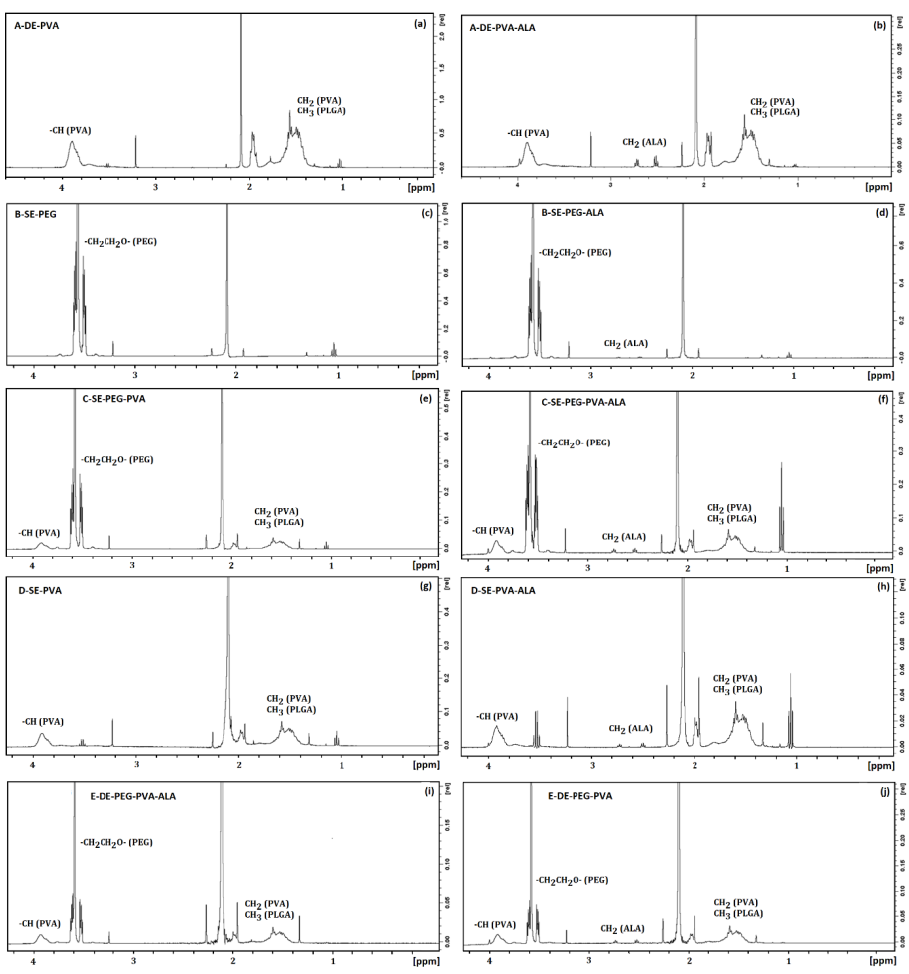
Figure 6. NMR spectra of ( a ) A-DE-PVA, ( b ) A-DE-PVA-ALA, ( c ) B-SE-PEG, (d) B-SE-PEG-ALA, ( e ) C-SE-PEG-PVA, ( f ) C-SE-PEG-PVA-ALA, ( g ) D-SE-PEG-PVA, ( h ) D-SE-PEG-PVA-ALA, ( i ) E- DE-PEG-PVA, ( j ) E-DE-PEG-PVA-ALA.